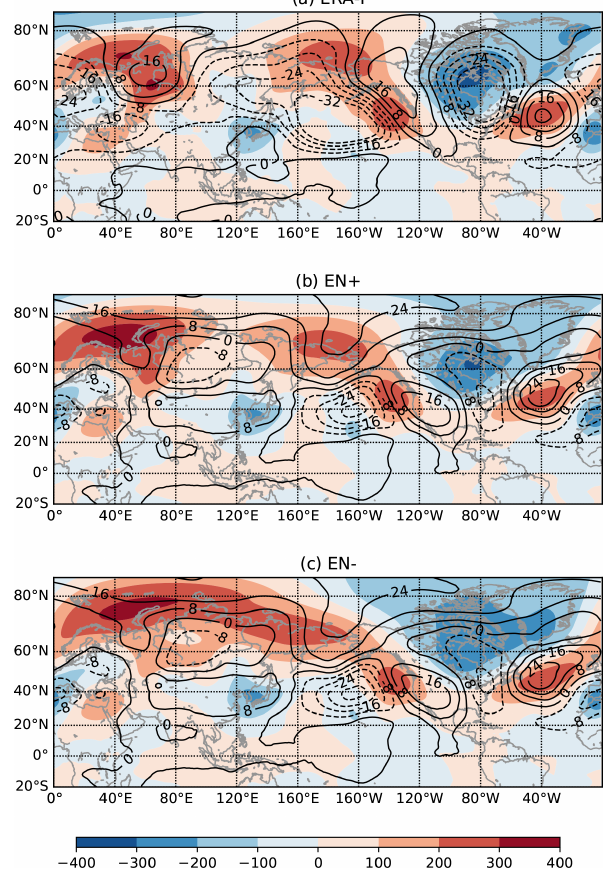
Figure 14. Geopotential height anomalies at 500hPa in (a) ERA- I, (b) ENS + members and (c) ENS − members. Contours show geopotential height composite ( m ) for MJO phase 6 averaged over lags of 5–9d. Shading shows anomalies averaged over 5–7 Febru- ary 2018. ERA-I composites are calculated using 1997–2017 data. Forecast model composites are calculated using hindcasts over the same